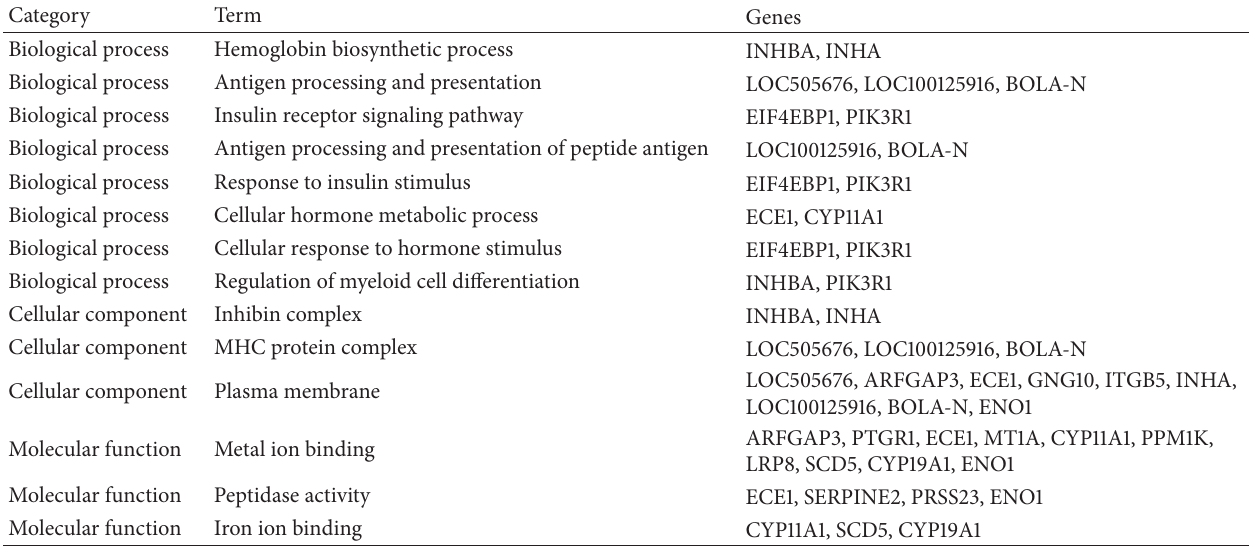
Table 4: GO analysis of genes upregulated in ODF1 versus PDF1.